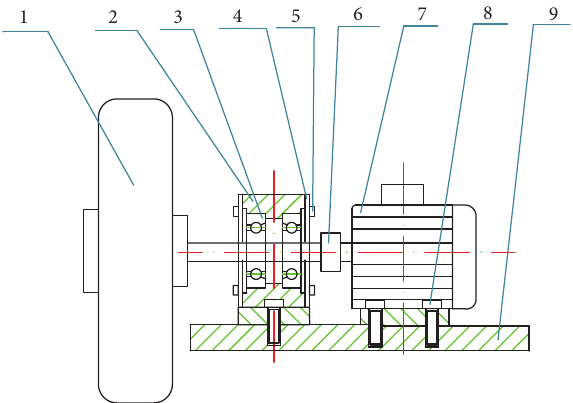
Figure 4: Walking mechanism of intelligent safety monitoring robot for coal mine shaft construction. (1) Driving wheel; (2) bearing pedestal; (3) ball bearing; (4) cover plate of bearing pedestal; (5) set screw; (6) connector; (7) driving motor; (8) set bolt; (9)